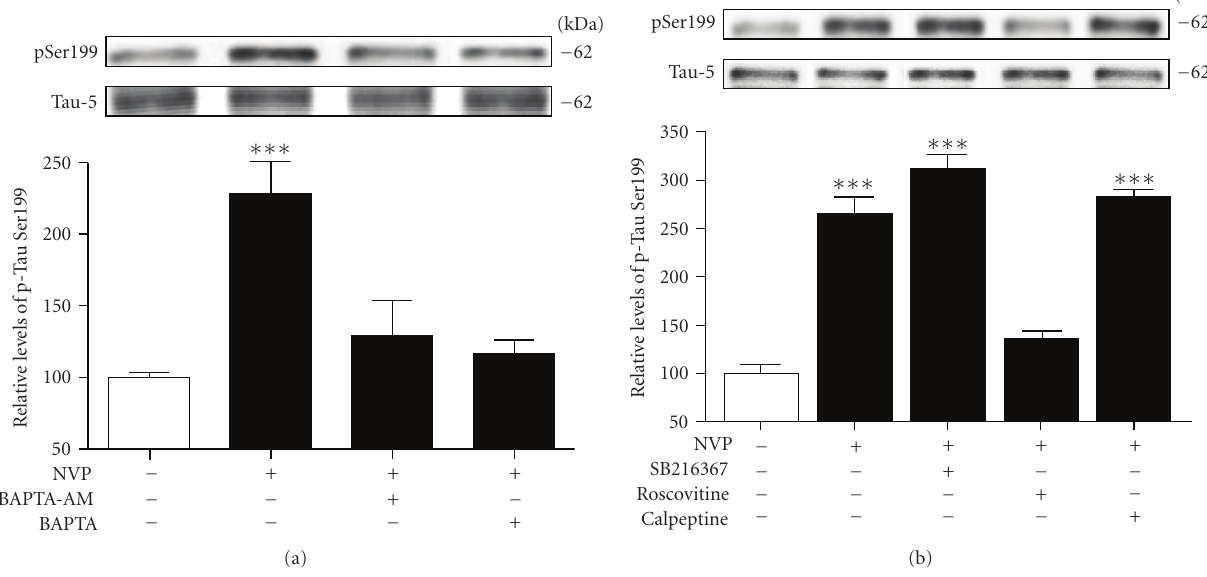
Figure 3: NVP-induced Tau phosphorylation is mediated by calcium and the Cdk5 pathway. (a) Phosphorylated Tau levels at Ser199 were estimated by Western blotting on cell extracts obtained from acute hippocampal slices treated with 50nM NVP for 2 hours alone or in combination with 10 μ M BAPTA-AM or 10 μ M BAPTA. The data are expressed relative to total Tau (i.e., Tau-5) levels. (b) As in A, except for the GSK-3 β inhibitor SB216367 (10 μ M), the Cdk5 inhibitor roscovitine (10 μ M), or the calpain inhibitor calpeptine (10 μ M) were employed. The data were expressed as percentage of control values and are means ± SEM of 3 measurements per cell extract obtained from 5 di ff erent rats. Statistical analysis was performed by one-way ANOVA followed by Neuman-Keuls’ post hoc test. ∗∗∗ P < . 001, drug-treated versus control.